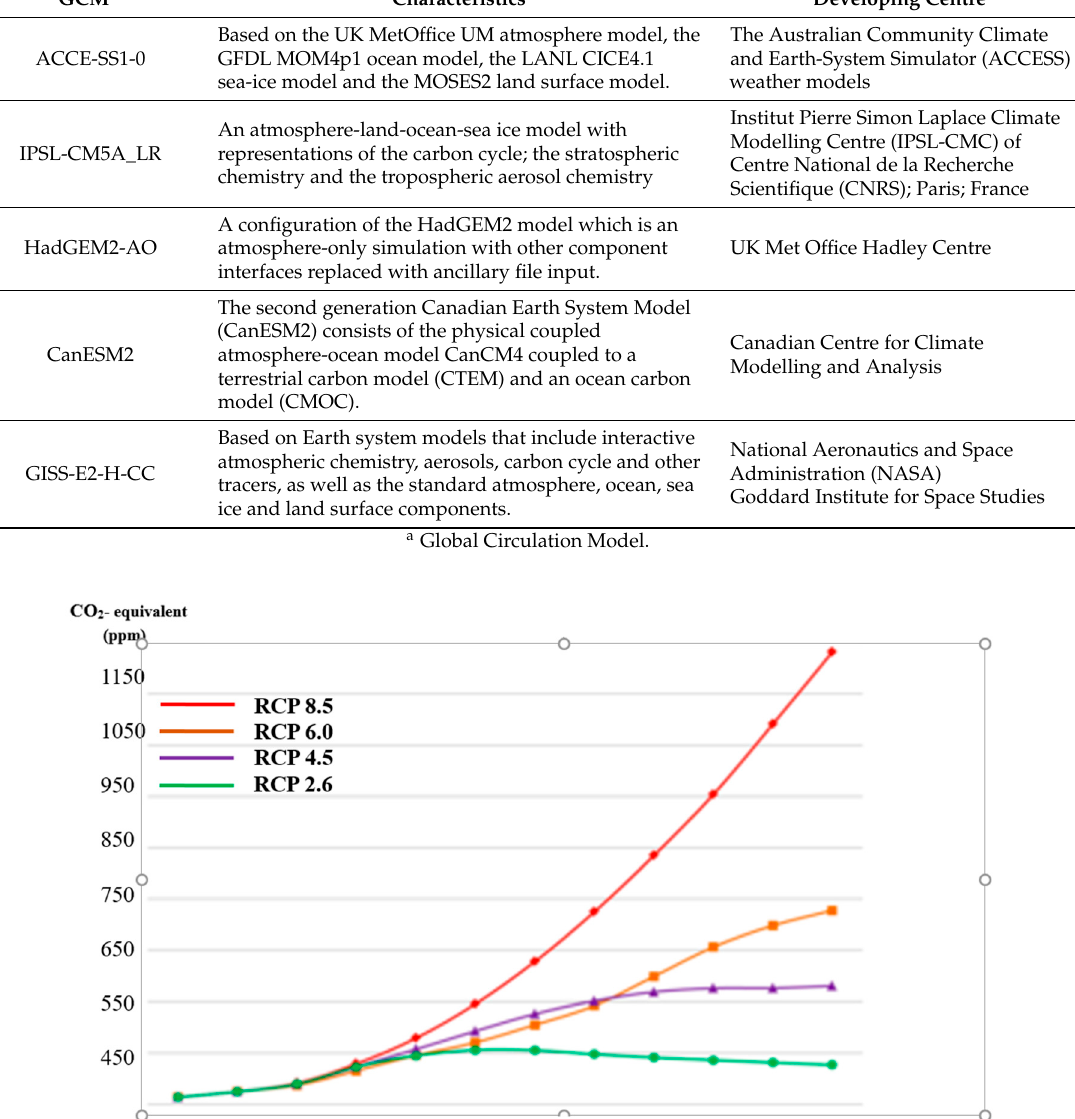
Table 1. The five global circulation models used in this study.